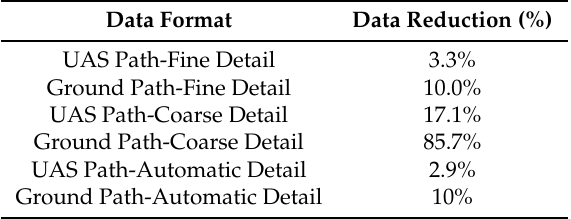
Table 3. Data reduction performance for a drone and dismounted